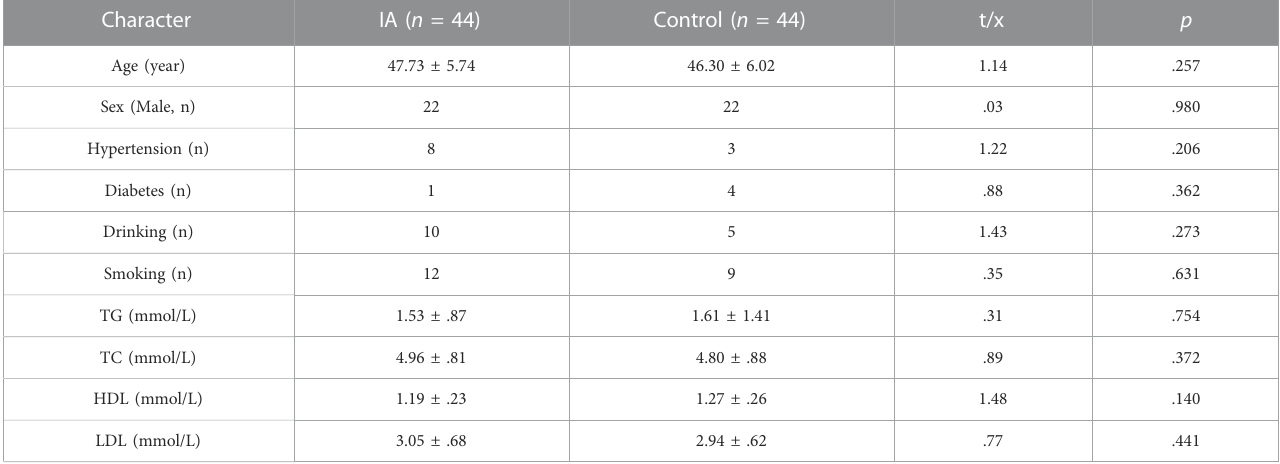
TABLE 1 The clinical characteristics of participants after propensity score matching.